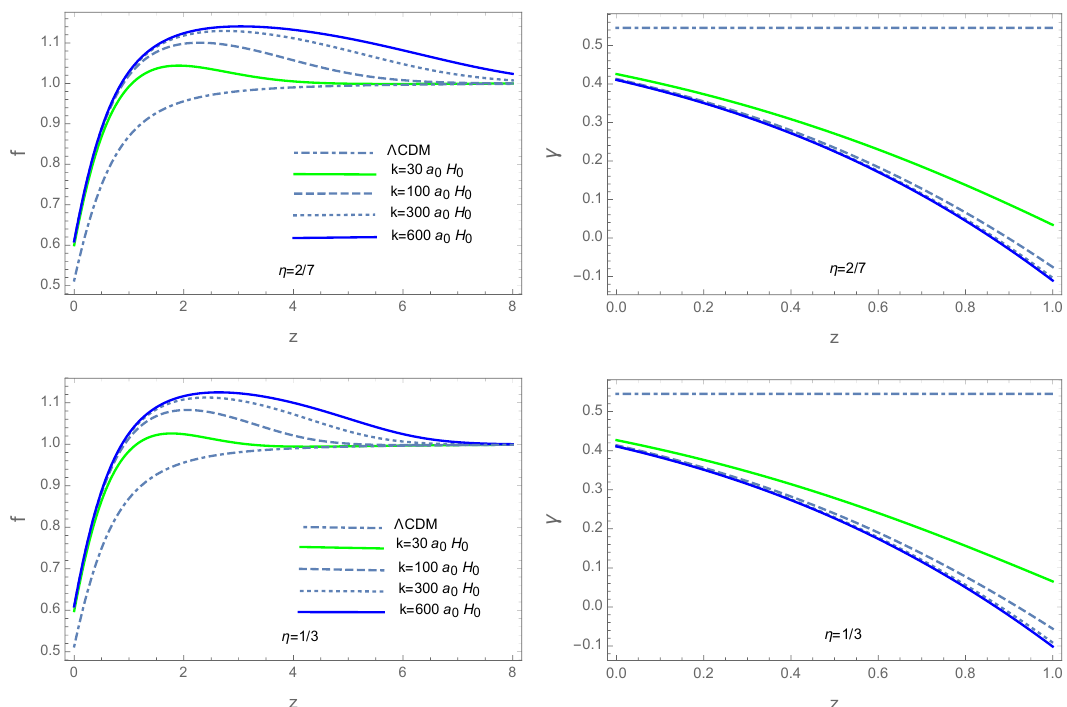
Figure 5 . The evolution of the growth rate f and the growth index γ for the model (3.36) for four different values of k . The upper figure corresponds to η = 2 / 5 , while the figure below corresponds to η = 1 / 3